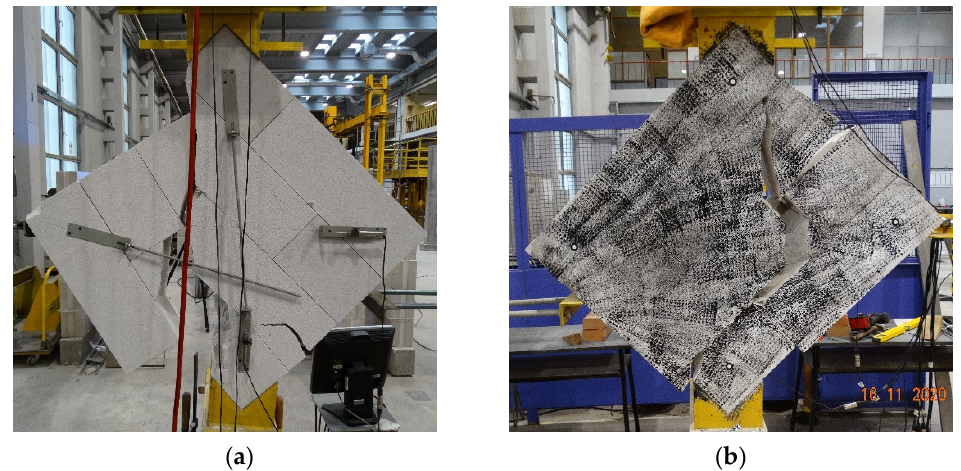
Figure 4. Damage of the unstrengthened wallets: ( a ) element no 1; ( b ) element no 2. The characteristics of the tested models were determined by the stress–strain relation- ship, which was linear in each case, with a proportional increase in stress as a function of the strain. So, the elements exhibited pseudo-elastic behavior, ending with the brittle failure of the wall. The stress–strain relationships of unstrengthened walls are shown on the graphs, along with the characteristics of the strengthened masonry walls, which allow a better assessment of the impact of strengthening.